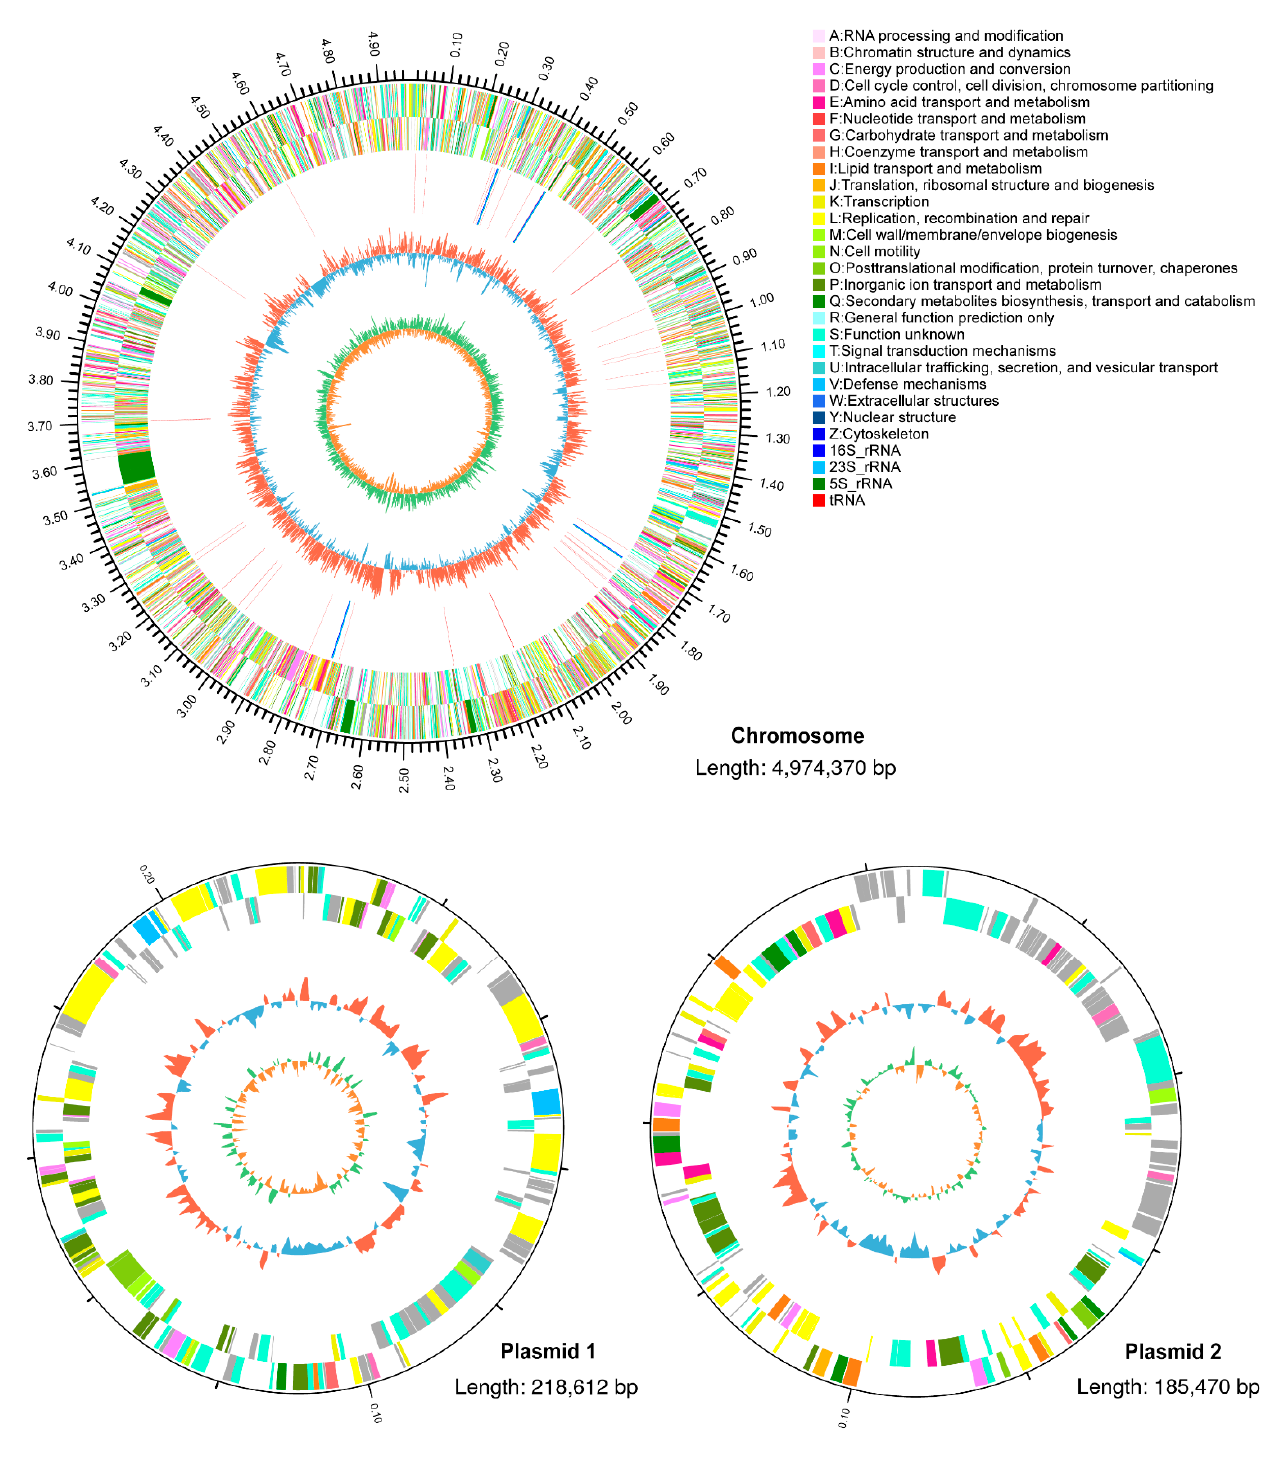
Figure 3. The whole genome of R. pyridinivorans 4-4. Circular representation of the genome with genomic annotation. The outer two rings (rings 1 and 2) represent the annotated genes, encoding proteins on the plus and minus strands, respectively. Different colors represent different COG categories for the corresponding genes. Ring 3 indicates non-coding RNAs. Ring 4 indicates the GC content (%), and ring 5 depicts the GC skew.